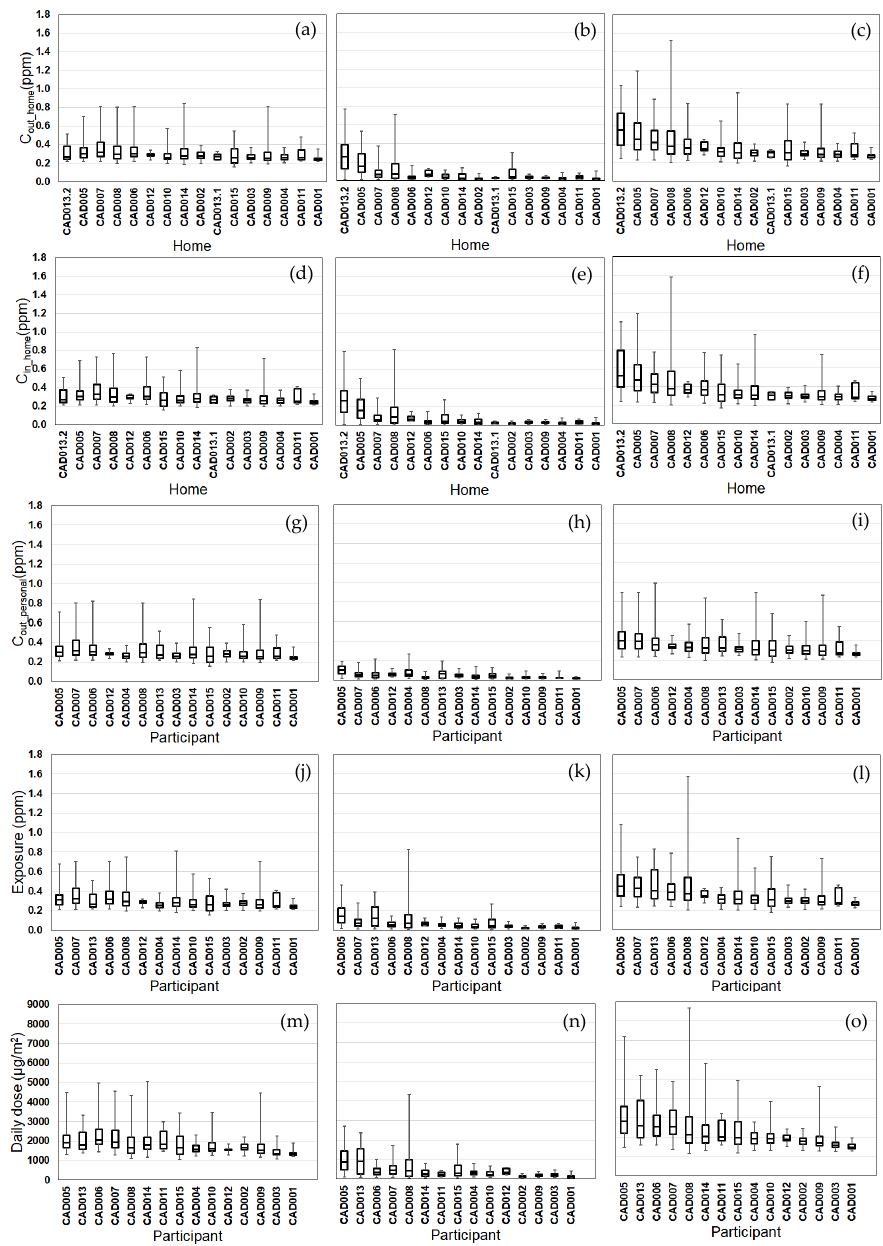
Figure 5. Modeled CO exposure metrics for Tier 1 (outdoor home concentrations; a – c ), Tier 2 (indoor home concentrations; d – f ), Tier 3 (personal outdoor concentrations; g – i ), Tier 4 (exposures; j – l ), Tier 5 (inhaled dose; m – o ) from background ( a , d , g , j , m ), on-road vehicle emissions ( b , e , h , k , n ), and total